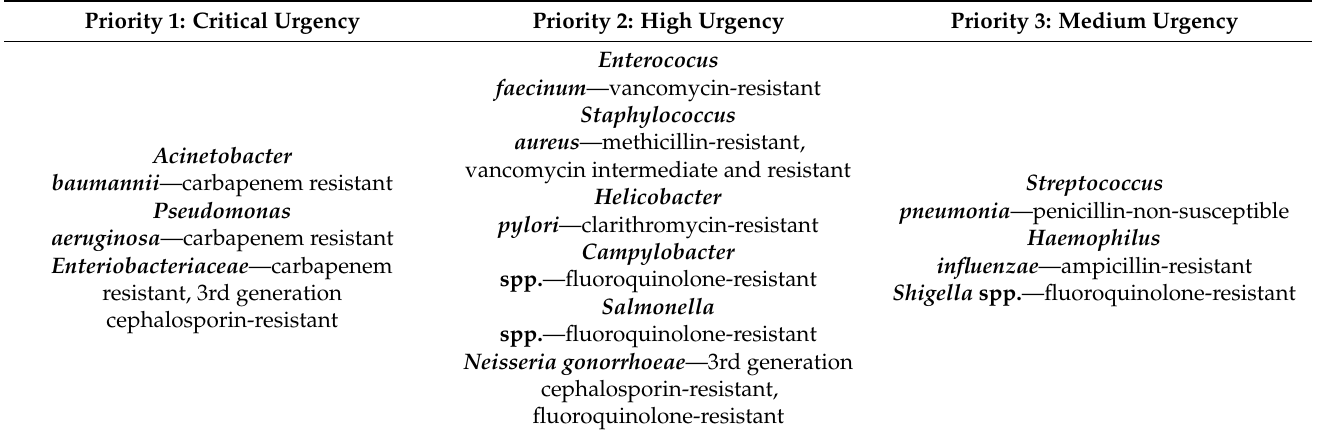
Table 5. WHO criticality on pathogens and resistance to